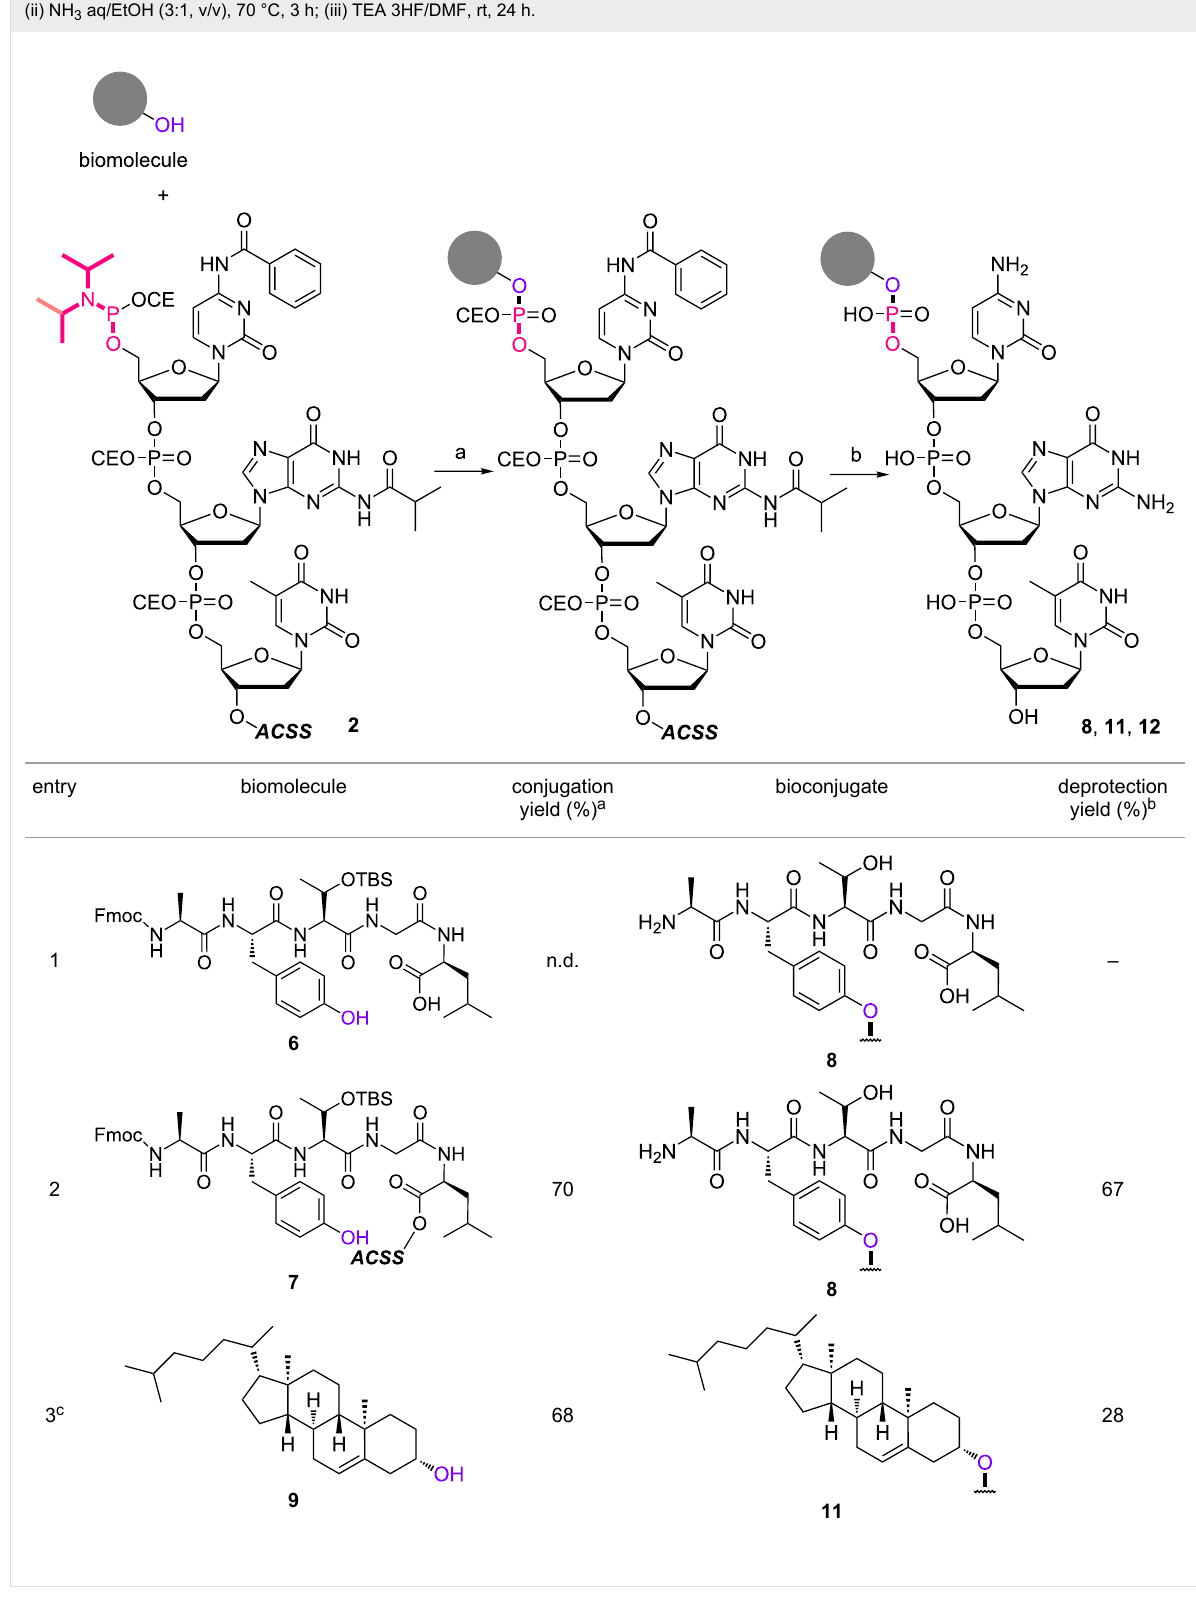
Table 2: Conjugation between the 5’-activated supported trinucleotide 2 and several biomolecules. Reagents and conditions: (a) (i) biomolecule (2.0 equiv), BMT (2.0 equiv), CH 2 Cl 2 /CH 3 CN/DMF (20:2:1, v/v/v), rt, 30 min; (ii) 0.67% BPO/DMP/CH 2 Cl 2 , rt, 30 min. (b) (i) 5% DCA/CH 2 Cl 2 , rt, 5